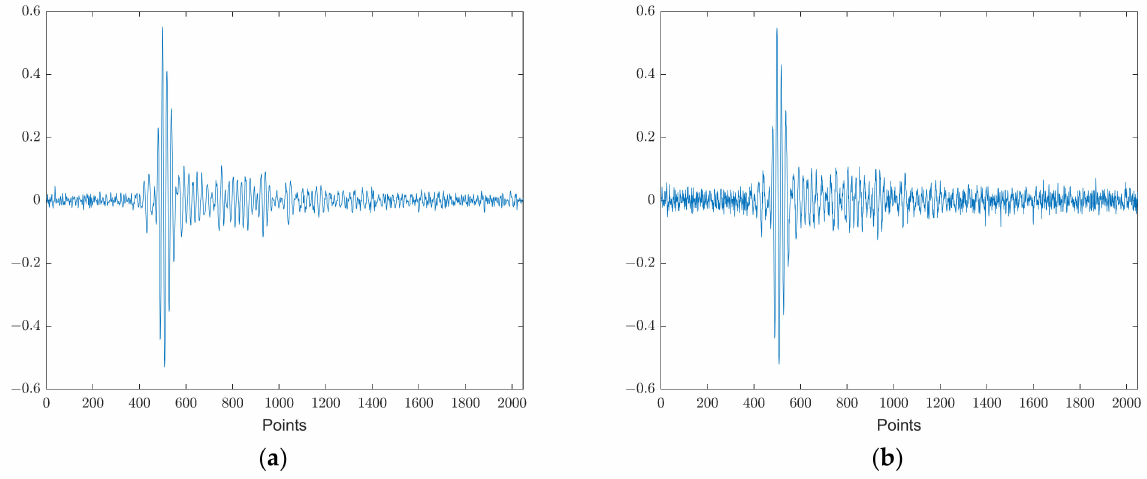
Figure 2. Additive WGN: ( a ) non-; ( b ) SNR